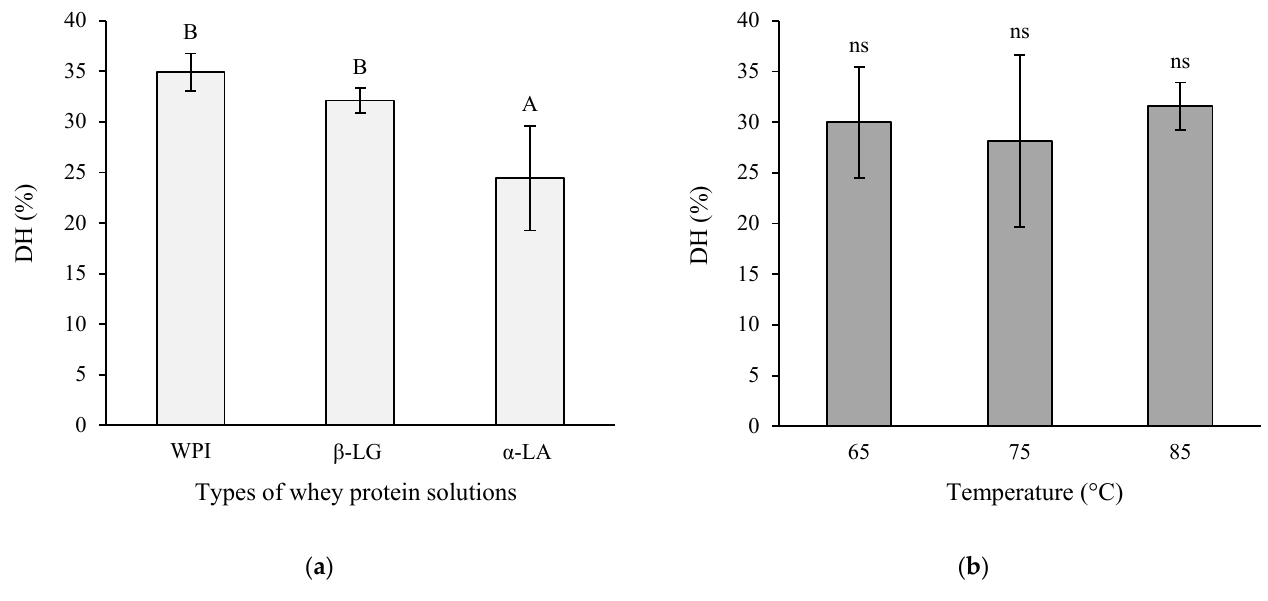
Figure 1. Degree of hydrolysis (DH, %) of protein hydrolysates: ( a ) Comparisons between different types of protein solutions (WPI, β -LG, and α -LA), and ( b ) comparisons between different heat treat- ment temperatures (65, 75, and 85 °C) for 30 min for all protein solutions. Data are presented as mean ± standard deviation ( n = 3). The different letters A,B indicate a significant difference at p < 0.05. The letter ns indicates no significant difference at p ≥ 0.05. WPI, β -LG, and α -LA denote whey protein isolate, β -lactoglobulin, and α -lactalbumin, respectively.